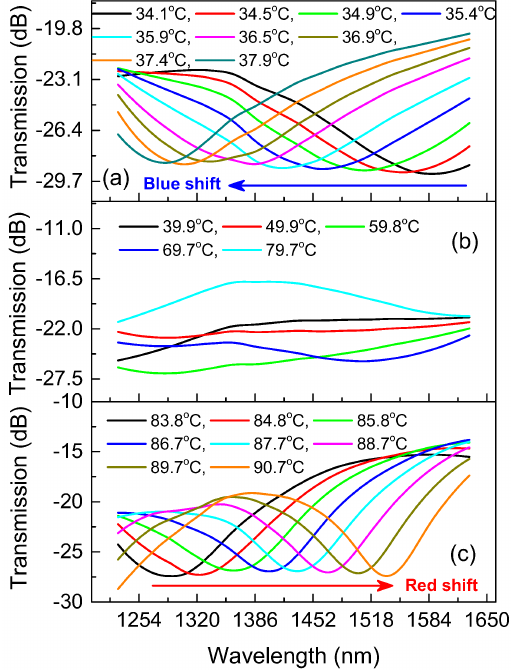
Figure 9. The transmission spectra evolution with the increase of environmental temperature, ( a ) 34.1 ◦ C~37.9 ◦ C, ( b ) 39.9 ◦ C~79.7 ◦ C, and ( c ) 83.8 ◦ C~90.7 ◦ C, for the device with cavity length of 456 µ m and filled liquid RI of